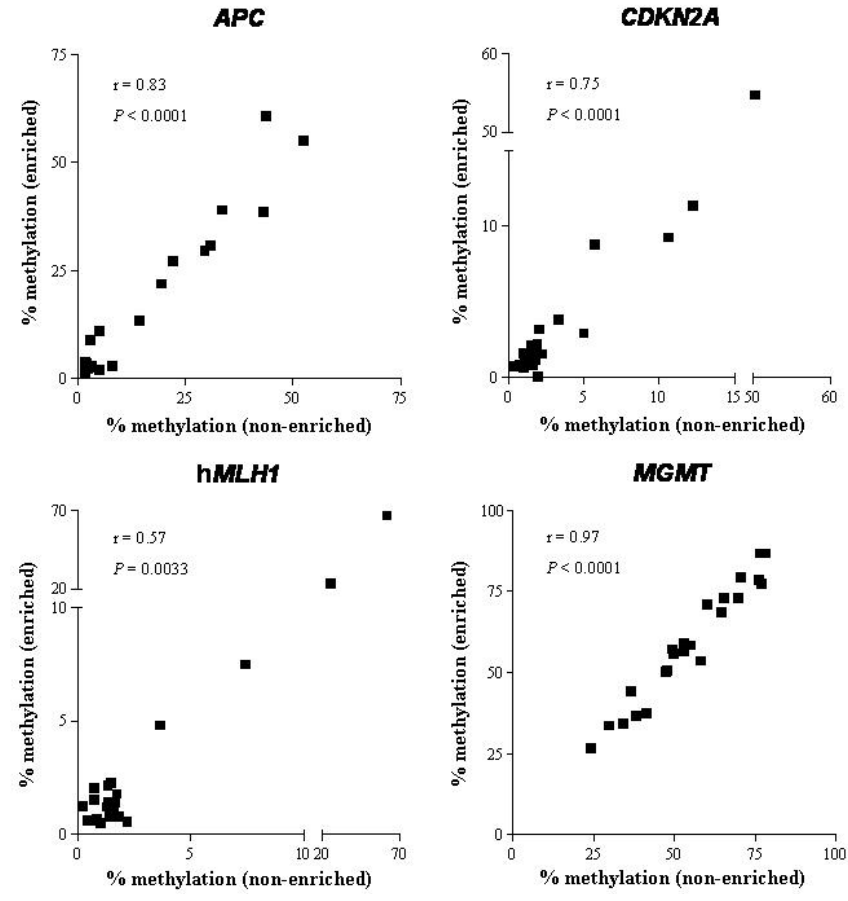
Figure 2. Correlation between the methylation values of the enriched and non-enriched samples. The panels represent the average percent methylation for all CpG loci analyzed in non-enriched ( X axis) and in enriched samples ( Y axis). Spearman’s correlation coefficients and p -values are